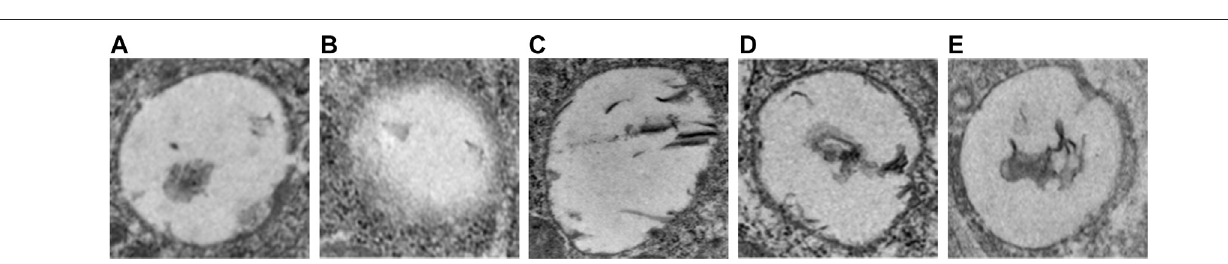
Frontiers in Pharmacology |